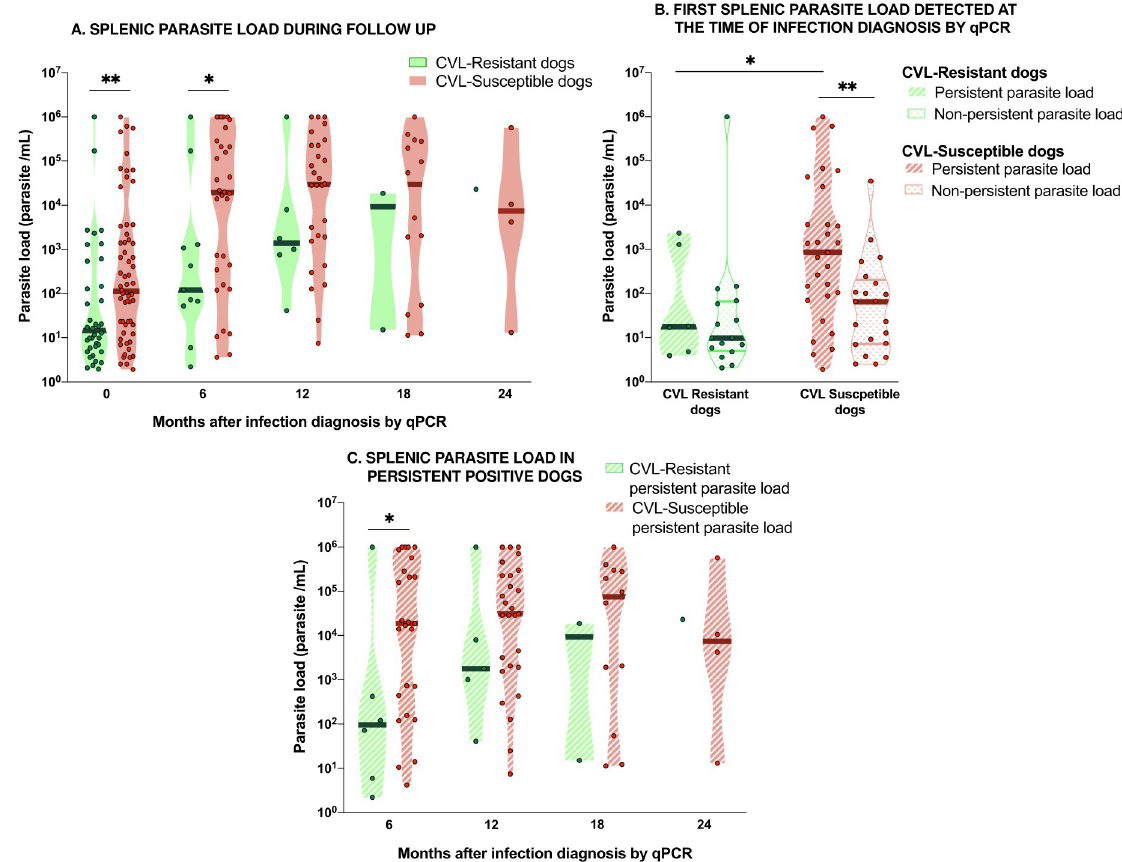
Fig 2. Splenic parasite load during follow-up in canine visceral leishmaniasis (CVL) resistant and susceptible dogs. (A) Splenic parasite load of resistant dogs (green dots, light green violin shape) and susceptible dogs (red dots, light red violin shape) assessed at the first time of qPCR infection diagnosis (0) and 6, 12, 18, and 24 months after first qPCR infection diagnosis. (B) First splenic parasite load detected by qPCR at the time of infection diagnosis of resistant dogs that would be persistent positive during follow-up (green dots, light green hatched violin shape), resistant non-persistent positive dogs (green dots, clear green hatched violin shape), susceptible dogs that would be persistent positive during follow-up (red dots, light red hatched violin shape), and susceptible dogs that would be non-persistent positive (red dots, clear red hatched violin shape). (C) Splenic parasite load of persistent positive susceptible dogs (red dots, light red hatched violin shape) and persistent positive resistant dogs (green dots, light green hatched violin shape) assessed at 6, 12, 18, and 24 months after first qPCR infection diagnosis. Only positive qPCR animals were included in these analyses. Asterisks indicate statistically significant differences ( � p < 0 . 05; �� p < 0 . 01 —Mann Whitney